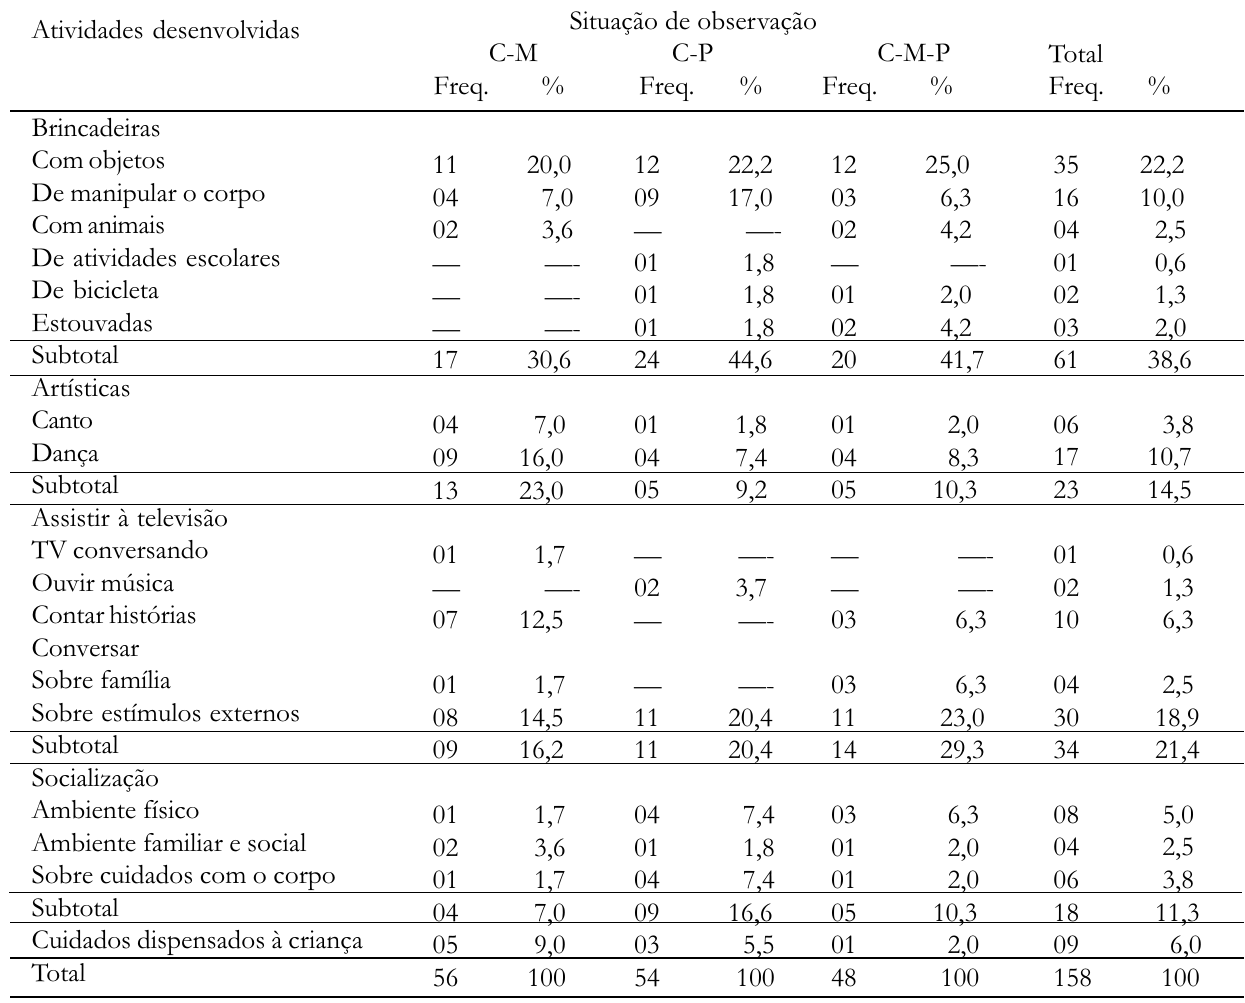
Tipos de Atividades Desenvolvidas por Genitores e suas Crian(cid:231)as, por Situa(cid:231)ªo de